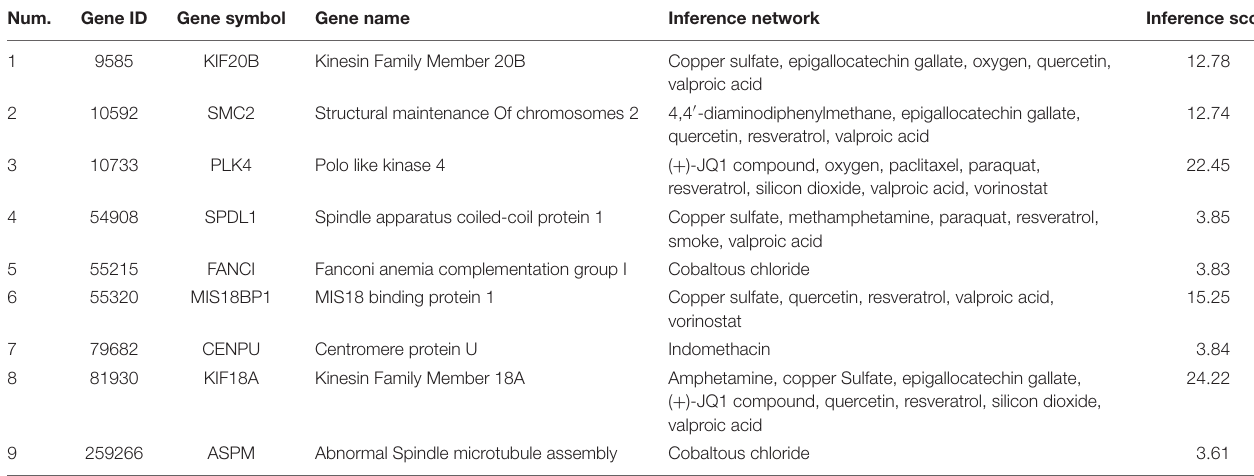
TABLE 4 | Chemicals that may affect the expression of hub genes in pulmonary arterial hypertension.